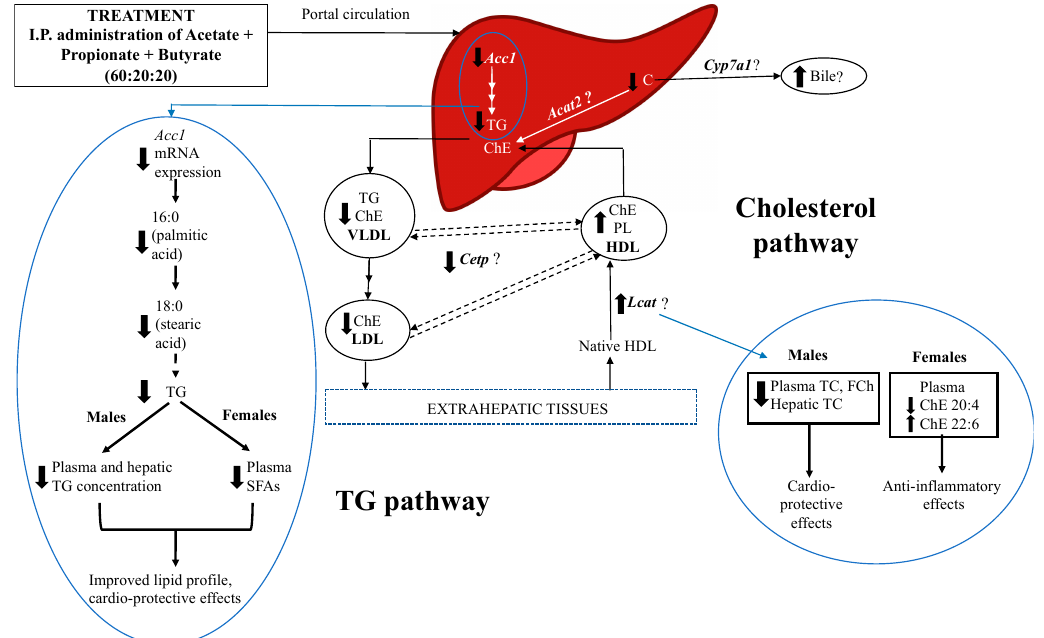
Figure 6. Proposed pathway by which SCFAs regulate lipid metabolism in a sex-specific manner in Long–Evans rats. Acetate, propionate, and butyrate, when administered intraperitoneally in a 60:20:20 ratio, enter portal circulation and reach the liver. Upon reaching the liver, SCFAs decrease the mRNA expression of Acc1 , thereby decreasing plasma and hepatic TG levels in males, while altering TG species composed of saturated fatty acids (SFAs) in females; these alterations may elicit cardio-protective effects. SCFAs likely alter the lipid and fatty acid composition of lipoproteins, which may influence the activity of associated enzymes, such as Lcat and Cetp, and be responsible for reduced levels of plasma TC and FC in males. Although no changes were observed in Cyp7a1 gene expression, it is possible that the bile acid production pathway is affected by SCFAs. SCFAs reduced the amount of arachidonic acid ( n -6 PUFA), while increasing the amount of docosahexaenoic acid ( n -3 PUFA) in ChE in only females, suggesting an anti-inflammatory effect. Overall, SCFAs may provide beneficial health effects to target metabolic disorders in both males and females via targeting the regulation of lipids and lipoprotein metabolism. Acat —acyl CoA:cholesterol acyl transferase, Acc1 —acetyl CoA carboxylase, Cetp —cholesteryl ester transfer protein, ChE—cholesteryl esters, Cyp7a1 —cholesterol 7a hydroxylase, FCh—free cholesterol, FFA—free fatty acids, HDL—high-density lipoprotein, I.P.—intraperitoneal, Lcat —lecithin cholesterol acyltransferase, LDL—low-density lipoprotein, PL—phospholipids, SCFAs—short-chain fatty acids, TC—total cholesterol, TG—triglycerides. Up and down arrows indicate an increase and decrease, respectively.